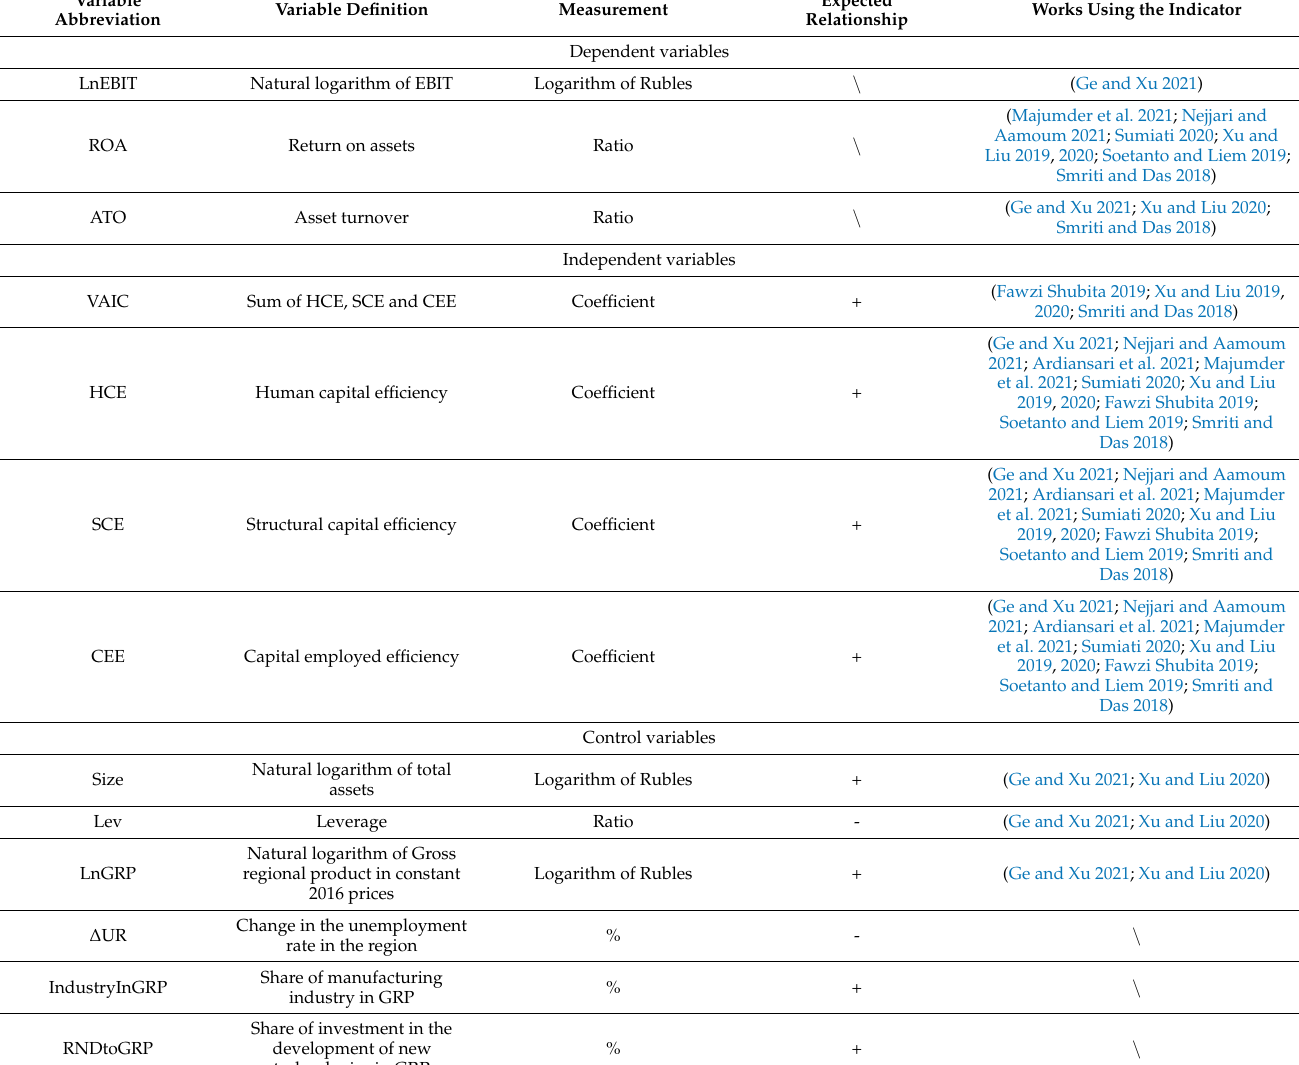
Table 1. Description of indicators used in the